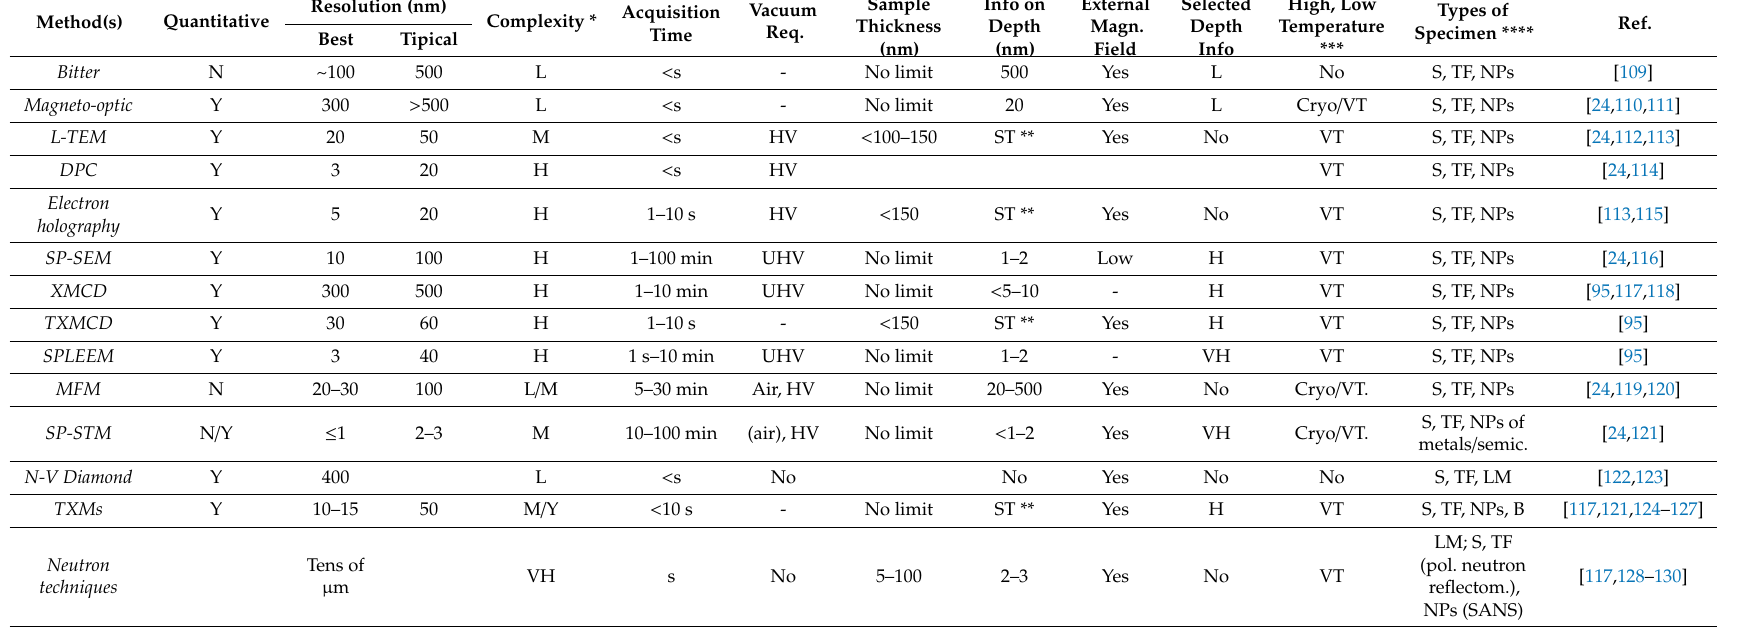
Table 1. Magnetic imaging methods and their